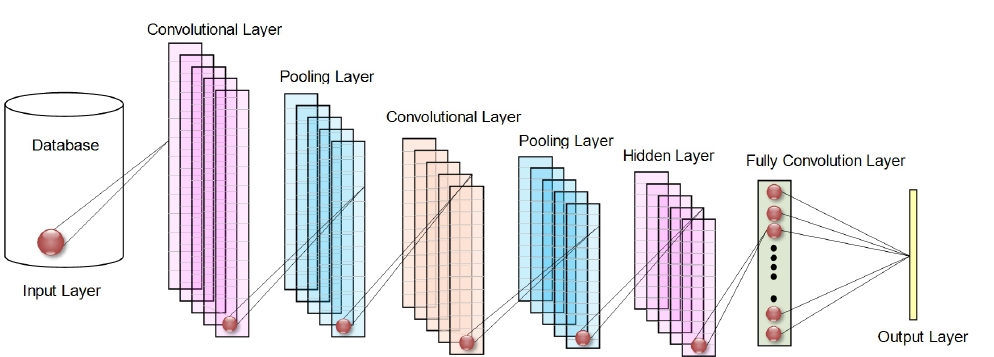
Figure 6. General structure of convolutional neural network (CNN) adopted in smart